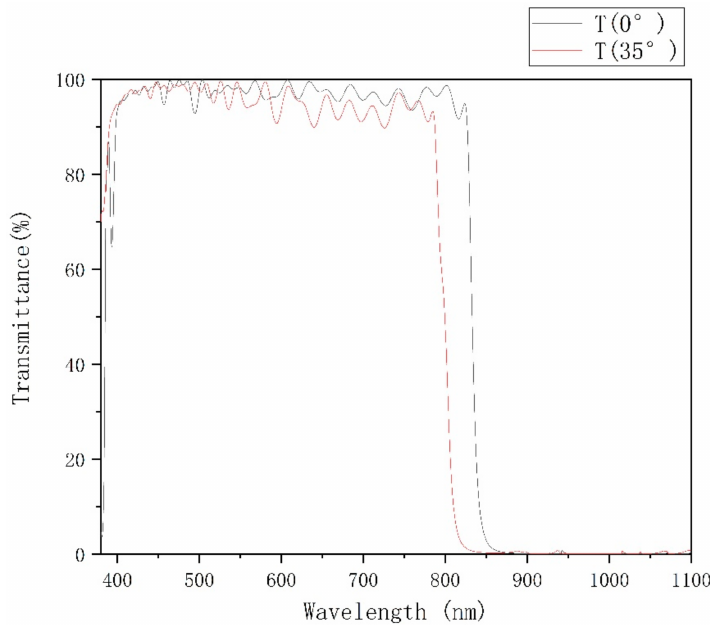
Figure 9. BPF Spectral test results for 0 ◦ and 35 ◦